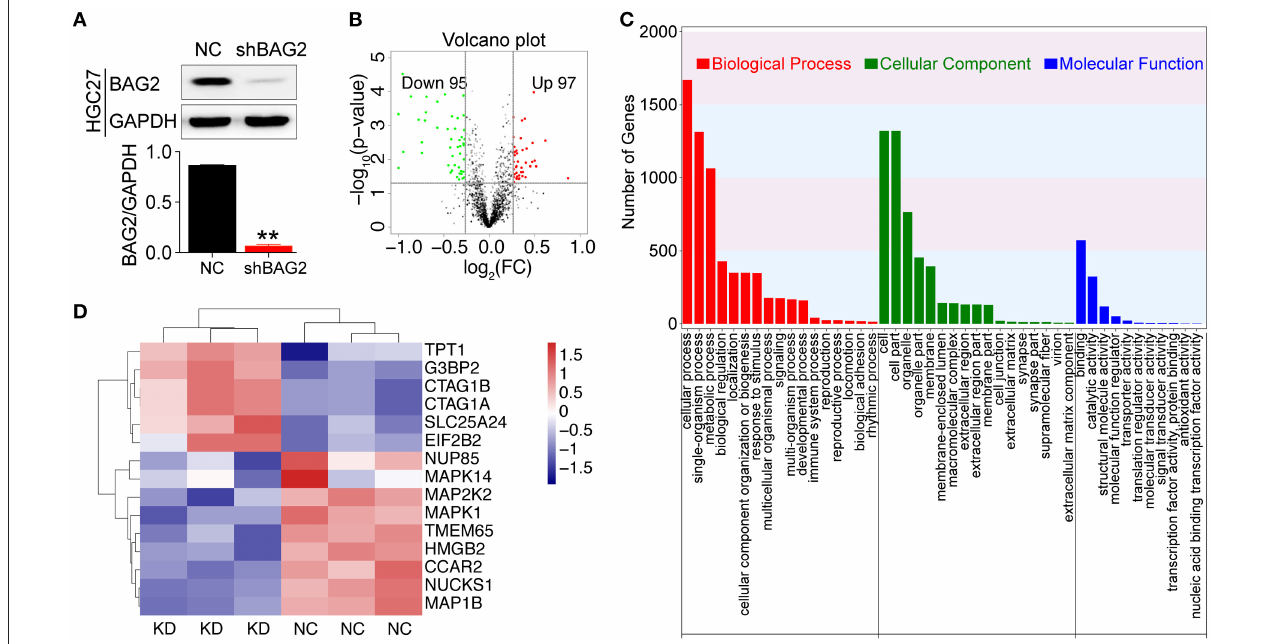
FIGURE 3 | Proteomic analysis after knockdown BAG2 . (A) Efficiency verification of shRNA for BAG2 knockdown in the HGC27 cell line (** p < 0.01); (B) Volcanic map of DEPs showed 97 up-regulated and 95 down-regulated (when the difference multiple was more than 1.2 times or < 1/1.2 times. The p -value was < 0.05 by t -test, which was regarded as DEPs); (C) iTRAQ proteomic analysis of biological processes (BP), cell component (CC) and molecular function (MF) in which BAG2 may be involved; (D) Clustering map of partial BAG2-related DEPs with statistical differences.